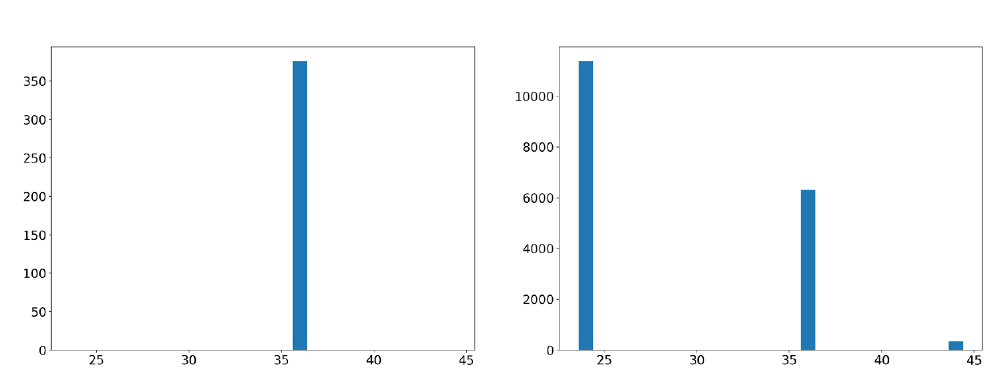
Figure 4 . The histograms of c 2 ; 1 for the 3-generation island in the left panel and all region in the right panel, where the horizontal and vertical axes represent the value of c 2 ; 1 and the number of models respectively.